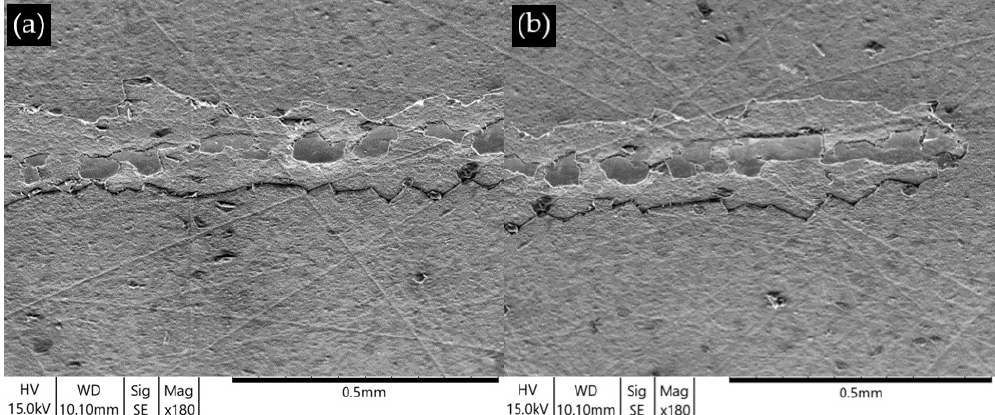
Figure 17. ( a ) Coating A scratch position 3 (continued delamination and spalling) and ( b ) Coating A scratch position 4 (end of the scratch SEM) at ×180